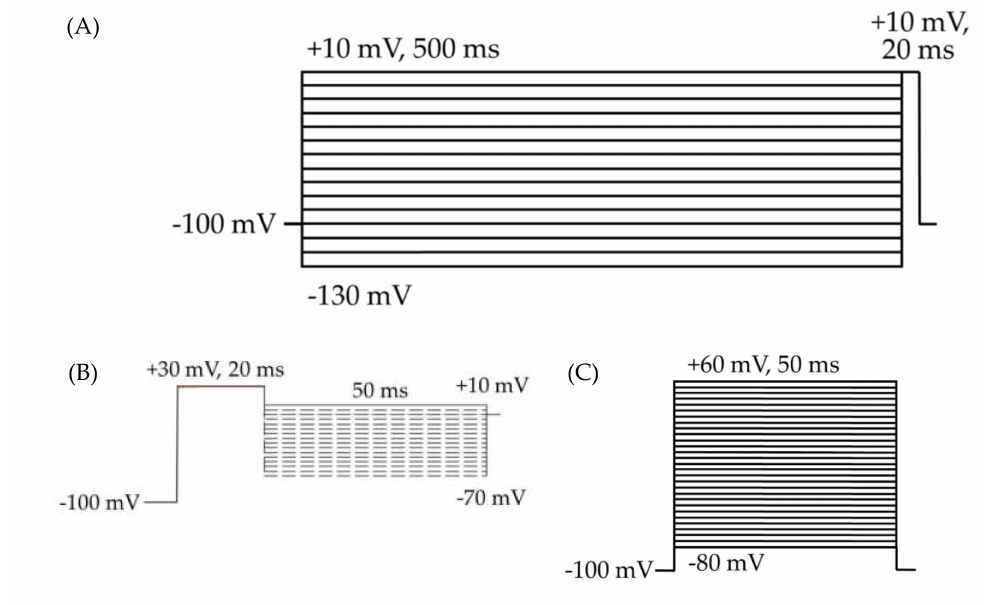
Figure 2. HEK cell electrophysiology voltage protocols. Cells were held at − 100 mV for all